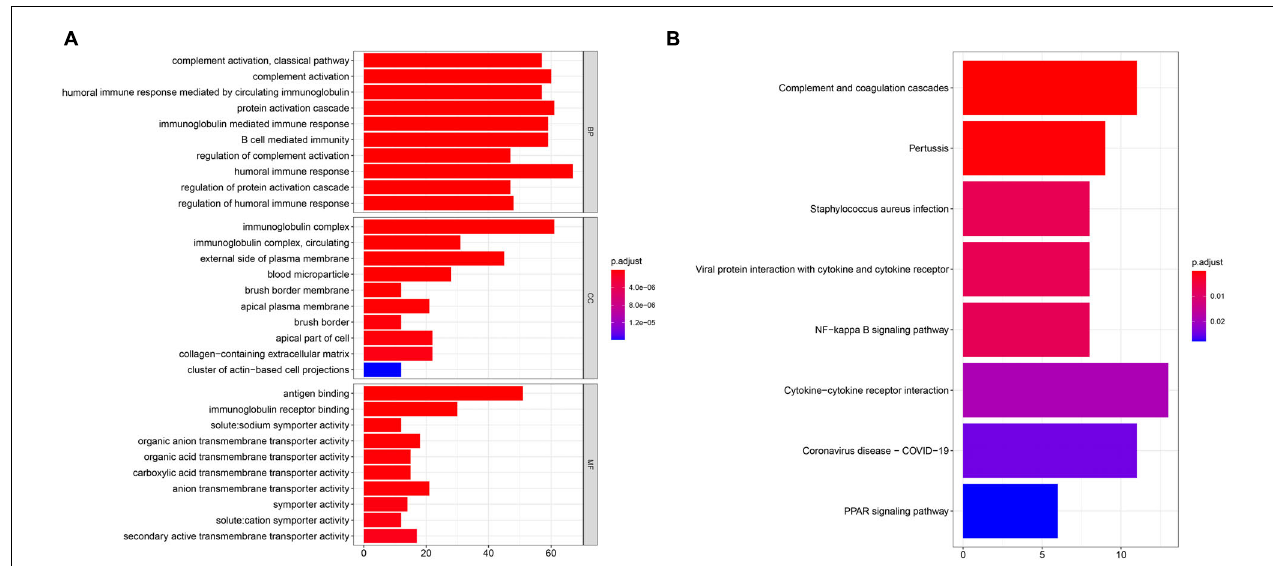
FIGURE 6 | GO (A) and KEGG (B) enrichment analysis was performed to identify potential function and pathway of